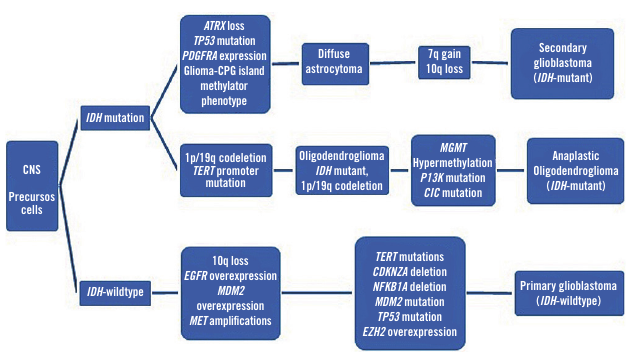
figurE − A possible model to establish the development of diffuse gliomas and progression to glioblastoma CNS: central nervous system; IDH: isocitrate